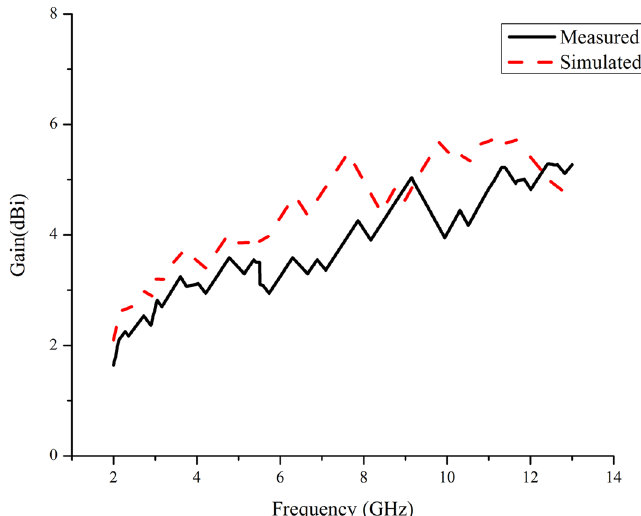
Fig. 7 Simulated and measured gain over UWB